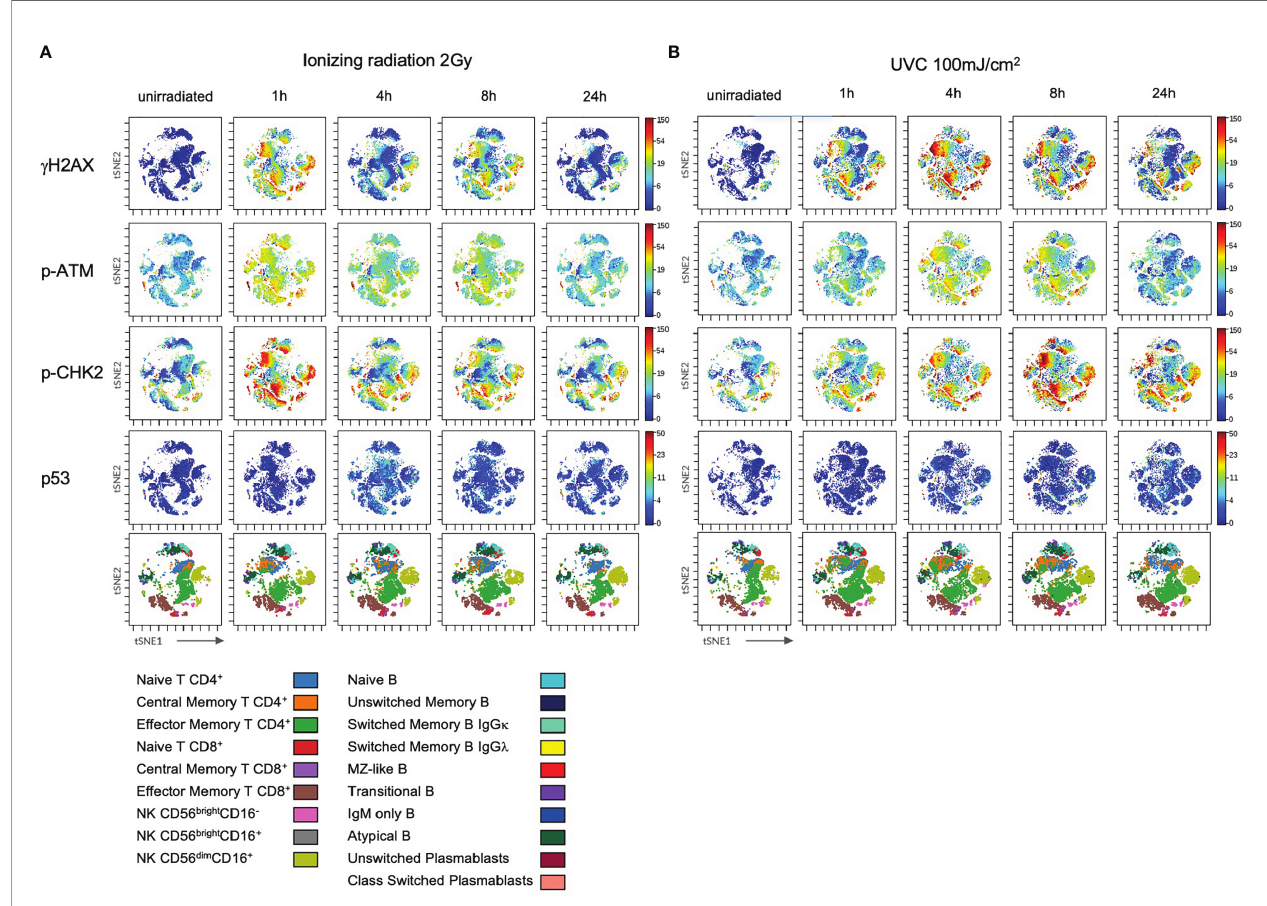
FIGURE 7 | DDR to ultraviolet C radiation is differential in lymphocyte subsets. PBMCs of healthy donors were thawed and cultured in RPMI media supplemented with 100U/ml human IL-2 for 96h before ionizing radiation with 2Gy (A) and UVC radiation with 100mJ/m 2 (B) . Cells were fi xed unirradiated, and 1h, 4h, 8h, 24h after radiation. Shown are tSNE Plots demonstrating expression level of DDR markers g H2AX, p-ATM, p-CHK2 and p53 on all populations at indicated time points. Scale bars on the right-hand side of each panel indicate intensities of DDR markers. The bottom panel of (A , B) , respectively, represent populations color coded by the legend underneath. Shown is one representative experiment obtained from one donor out of